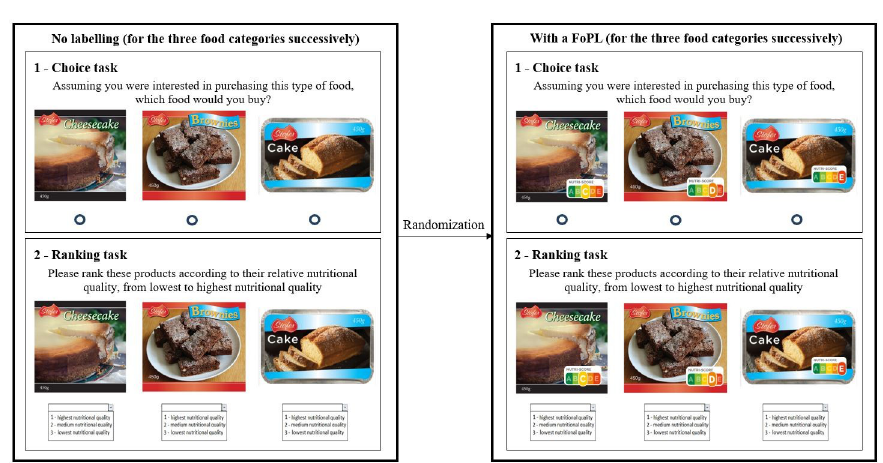
Fig 2. Procedure of the choice and ranking tasks for the cakes category. After the choice and ranking tasks, participants were invited to respond to questions about their perceptions on the FoPL to which they had been exposed. Various dimensions were assessed including liking (e.g. “I like this label”), usefulness (e.g. “This FoP label is useful”), awareness (e.g. “This FoP label stands out”), and perceived cognitive workload for the comparison of pre-packed foods within the same food category (e.g. “This label is easy to understand”). For each question, respondents provided their responses on a 9-point Likert scale ranging from “Strongly disagree” to “Strongly